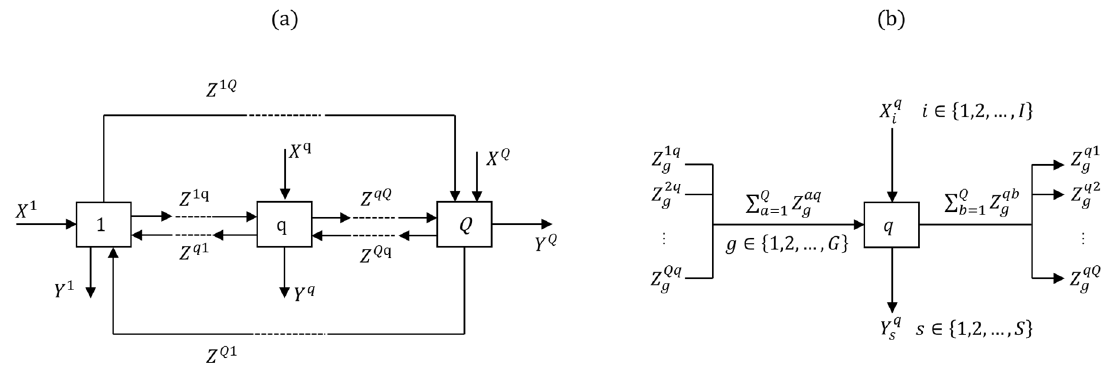
Figure 1. ( a ) The general structure of the network system. ( b ) The th division in the system.